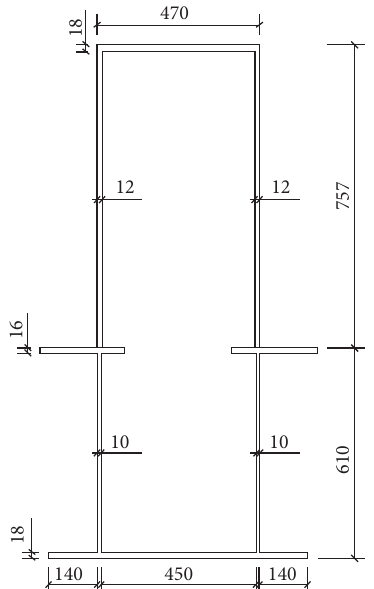
Figure 11: Diagram of strengthened cross section (unit: mm).